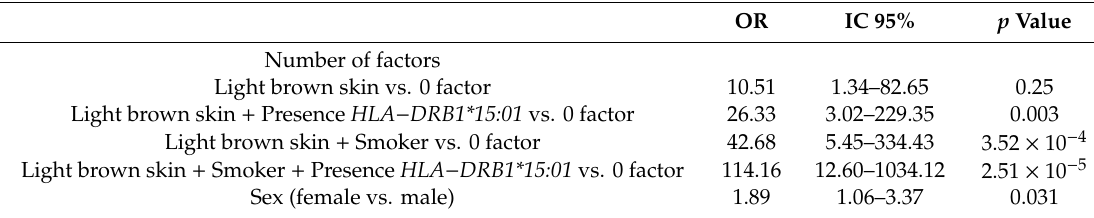
Table 3. Accumulative risk